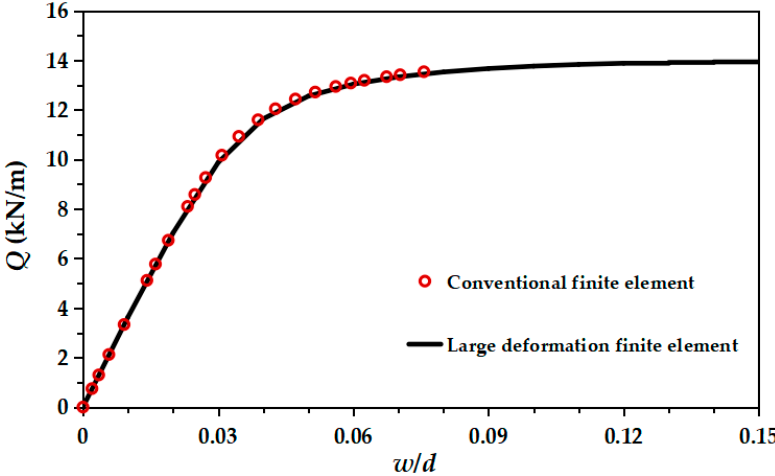
Figure 3. Normal resistances using the conventional and large deformation fi nite element ap-